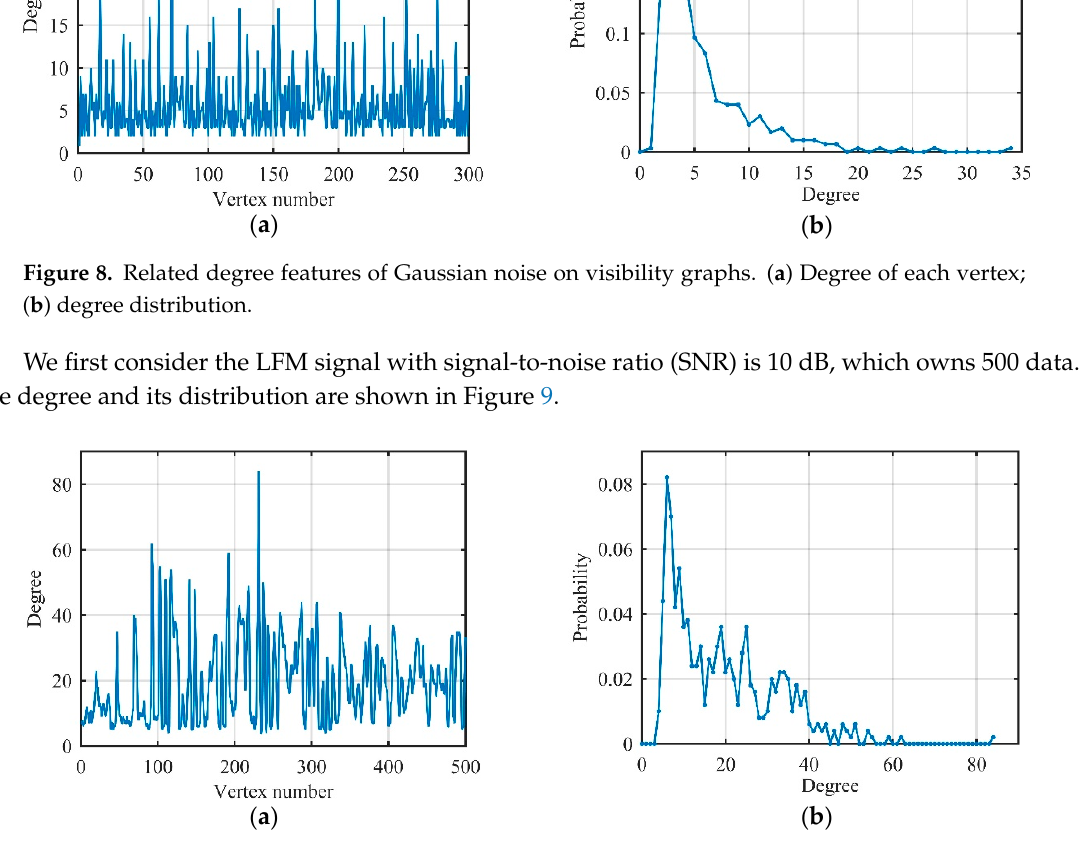
Figure 9. Related degree features of LFM signal on visibility graphs (signal-to-noise ratio (SNR) = 10 dB). ( a ) Degree of each vertex; ( b ) degree distribution.